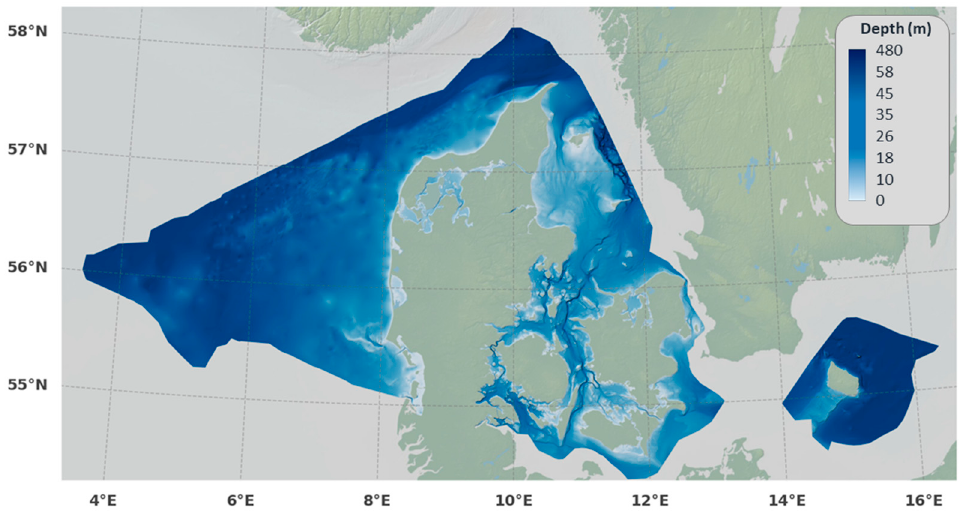
Figure 4. The bathymetric layer of Denmark’s Depth Model. The depth values in the color legend are in meters. The Global Multi-Resolution Topography (GMRT) version 4.0 is shown in the background.